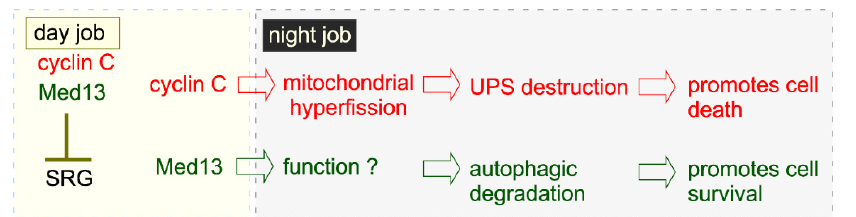
Figure 6. Similarities and differences between cyclin C and Med13’s state following stress. See text for details. SRG—stress response genes, UPS—ubiquitin proteasome system. As highlighted in this review, S. cerevisiae is an excellent experimental model for under- standing both cell death and cell survival responses with respect to CKM function [95,207,240].